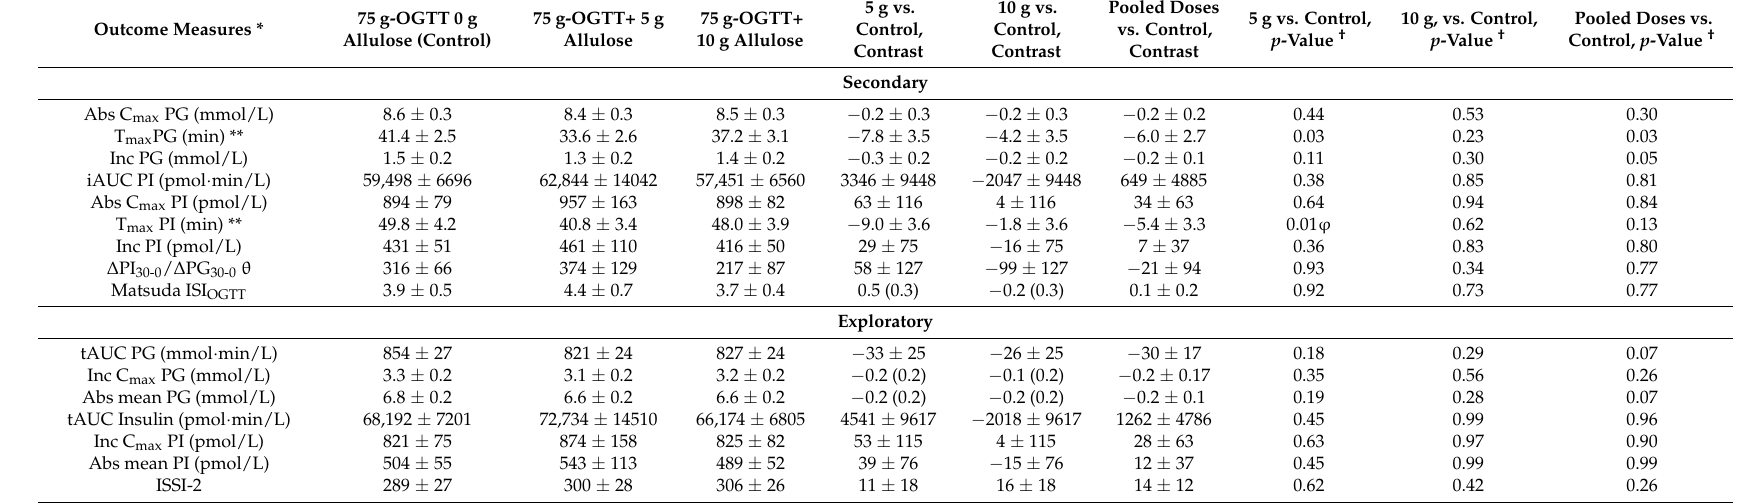
Table 3. Secondary and exploratory outcomes for the effects of allulose on postprandial carbohydrate